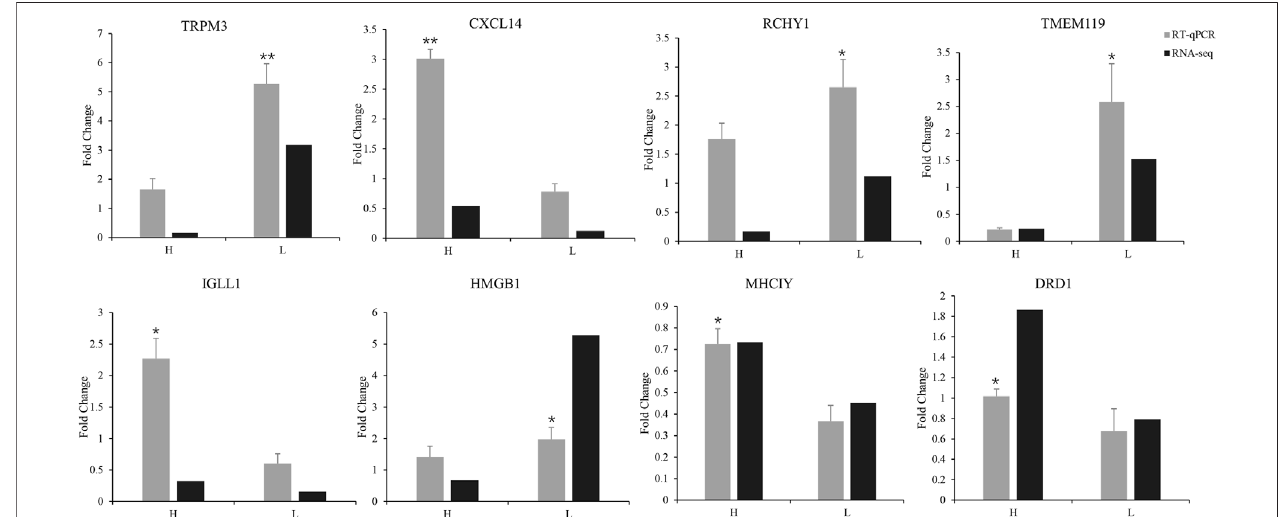
FIGURE 3 | RT-qPCR validation of the expression of eight differentially expressed genes compared with mRNA transcriptome sequencing results (* p < 0.05, ** p < 0.01).